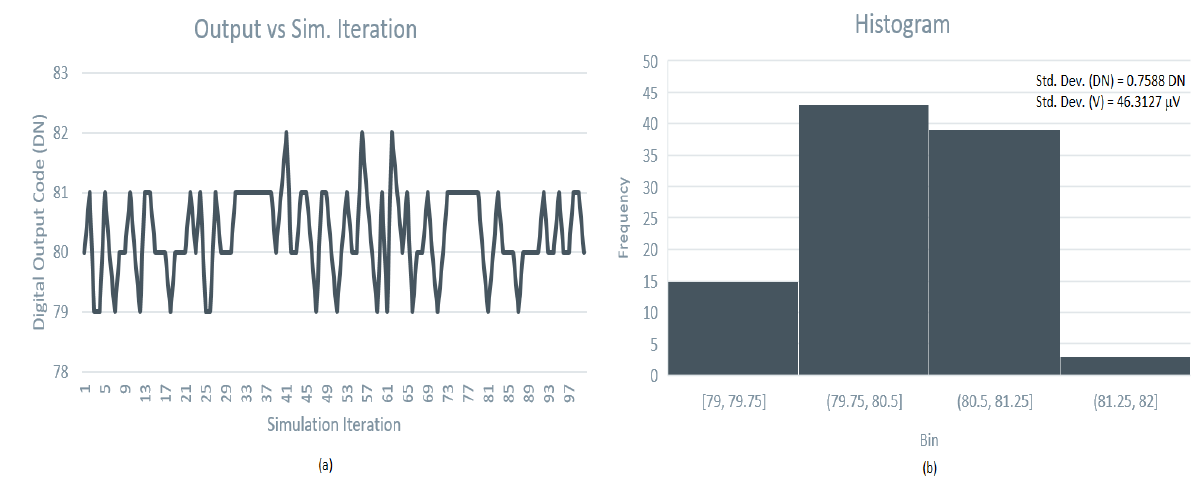
Figure 12. Transistor level Transient-Noise simulation with ADC output noise measurement under Digital CDS operation. ( a )—ADC output digital codes as a function of the simulation run (equivalently the noise performance in the dark); ( b )—the corresponding digital output codes occurrence frequency through a histogram.